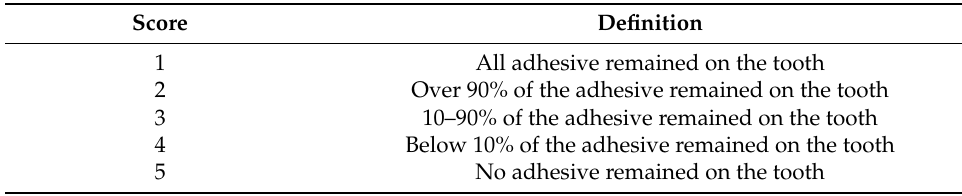
Table 2. Adhesive remnant index (ARI)